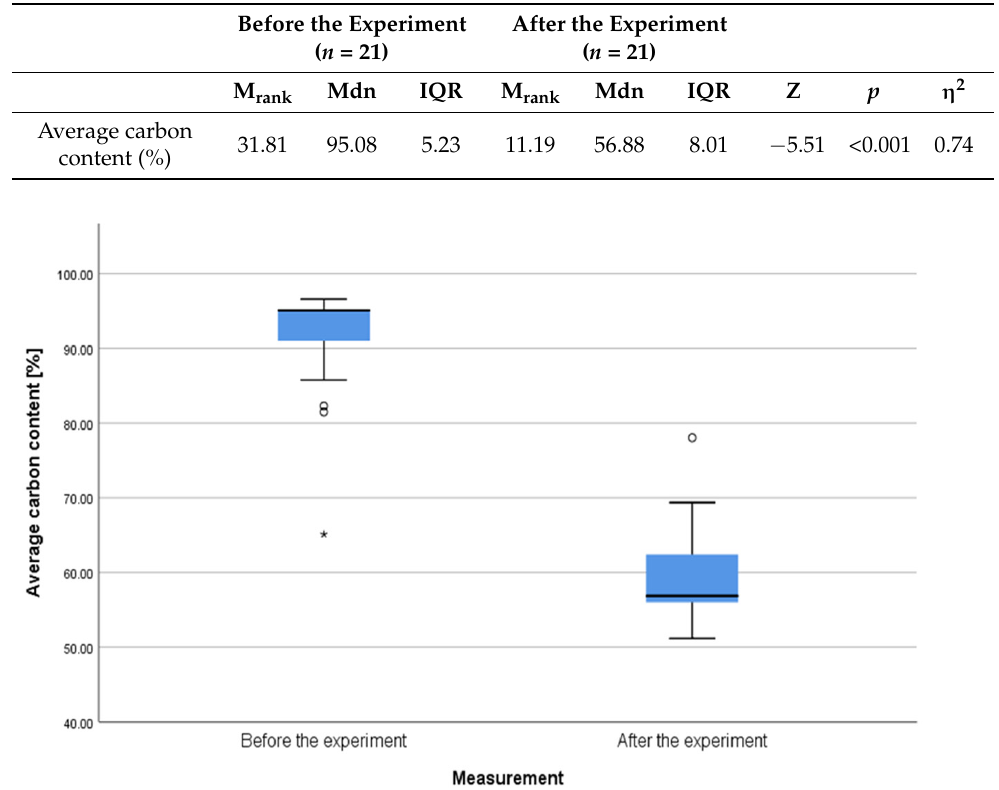
Figure 3. Box plots for the average carbon content (%) broken down into measurements before and after the experiment. *—before the experiment, ◦ —after the